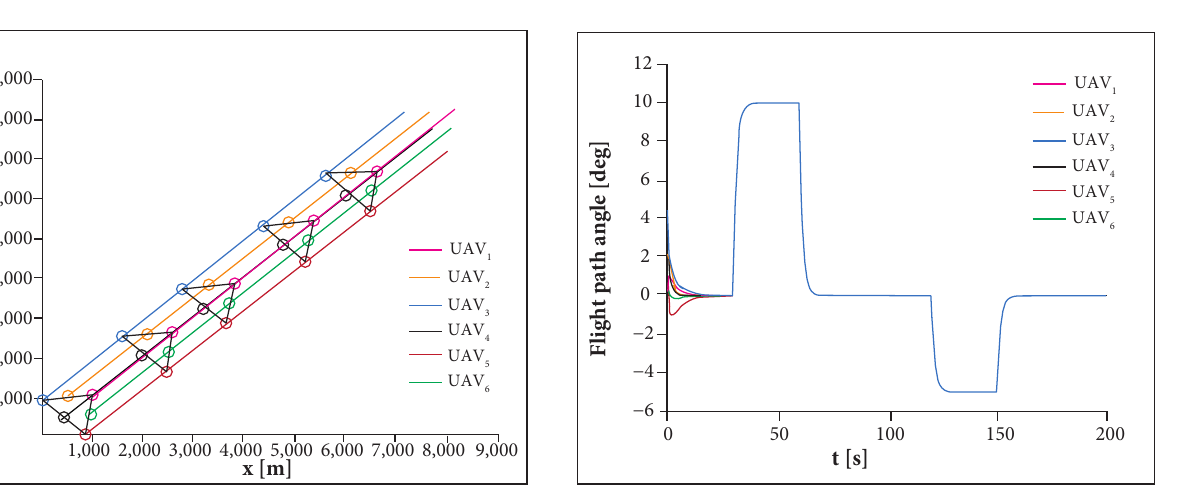
figure 11. Time histories of the flight path angle. figure 6. Top view of UAVs’ formation flying.